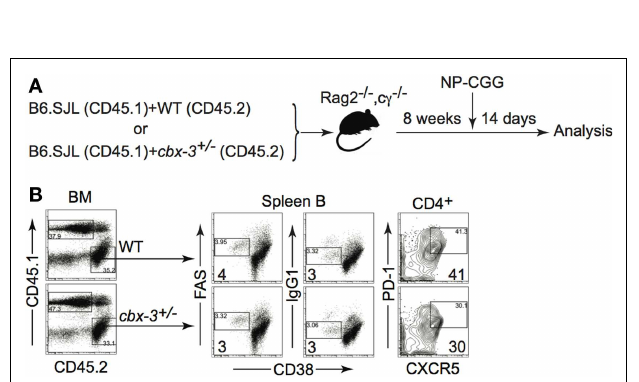
FIGURE 5 |TheT follicular helper cell copulation is reduced in cbx-3 + / − mice . (A) The frequency of spleenTCR β + CD4 + CXCR5 hi PD-1 hi T FH population was determined by FACS analysis. Numbers in right bottom corners indicate the percent cells. CXCR5 hi PD-1 hi T FH cells were gated on theTCR β + CD4 + population. (B) Plot represents a compilation of the percent ofT FH population from (A) . Each symbol denotes an individual mouse. Bars represent median. Statistical analysis was performed with GraphPad one-way ANOVA. Day 14, n = 8–12 for each genotype, **** p < 0.0001.